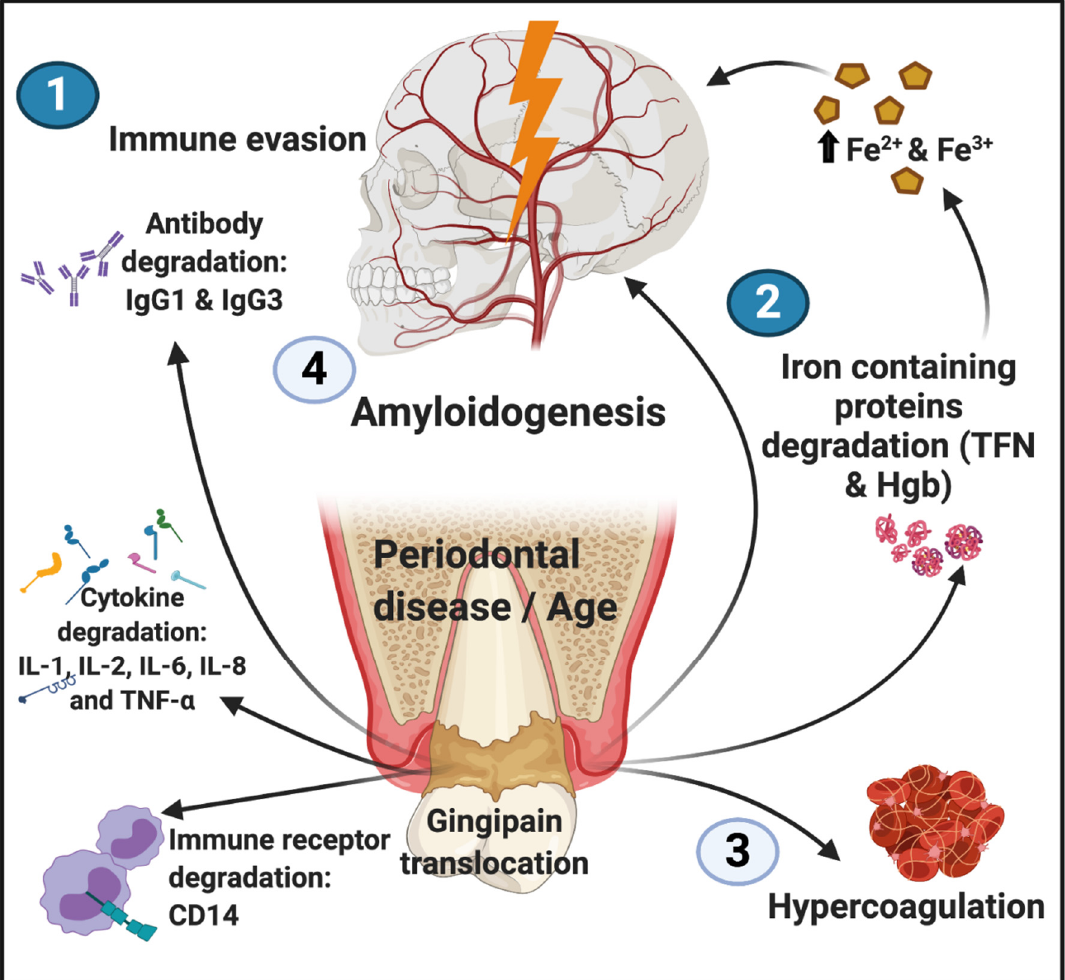
Figure 5. An overview of the effects of the translocation of bacterial gingipain into the circulation: (1) immune evasion brought about by proteolytic degradation of antibodies, cytokines, and immune receptor CD14; (2) proteolytic degradation of transferrin (TFN) and haemoglobin (Hgb); (3) hypercoagulation caused directly by contact of platelets with gingipain proteases; and (4) amyloidogenesis, resulting not only from direct contact of neurons with gingipain proteases but also indirectly as a result of increased iron levels, which occur due to the degradation of iron-containing proteins.